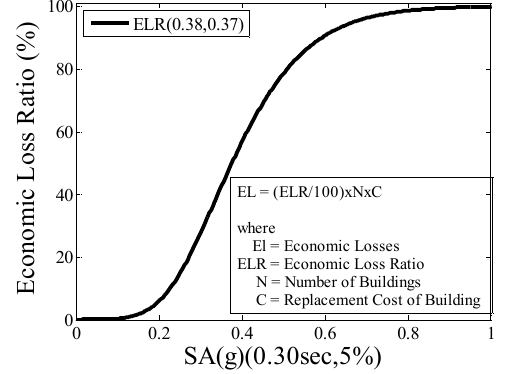
Figure 12 Vulnerability function for Himalayan DS masonry structures obtained using the FEMA (2003) economic consequence factor. Vulnerability functions for human casualties are derived from the collapse fragility function of the buildings. For this purpose the human consequence factor HCF developed by Spence (2007b) is employed in the present study. It includes the convolution of the collapse fragility function with the loss ratio of the Spence model. This model assigns ratio of slight injuries with 0.50, moderate injuries with 0.12, serious injuries with 0.08, critical and deaths with 0.064, in collapsed buildings. Figure 13 reports loss which